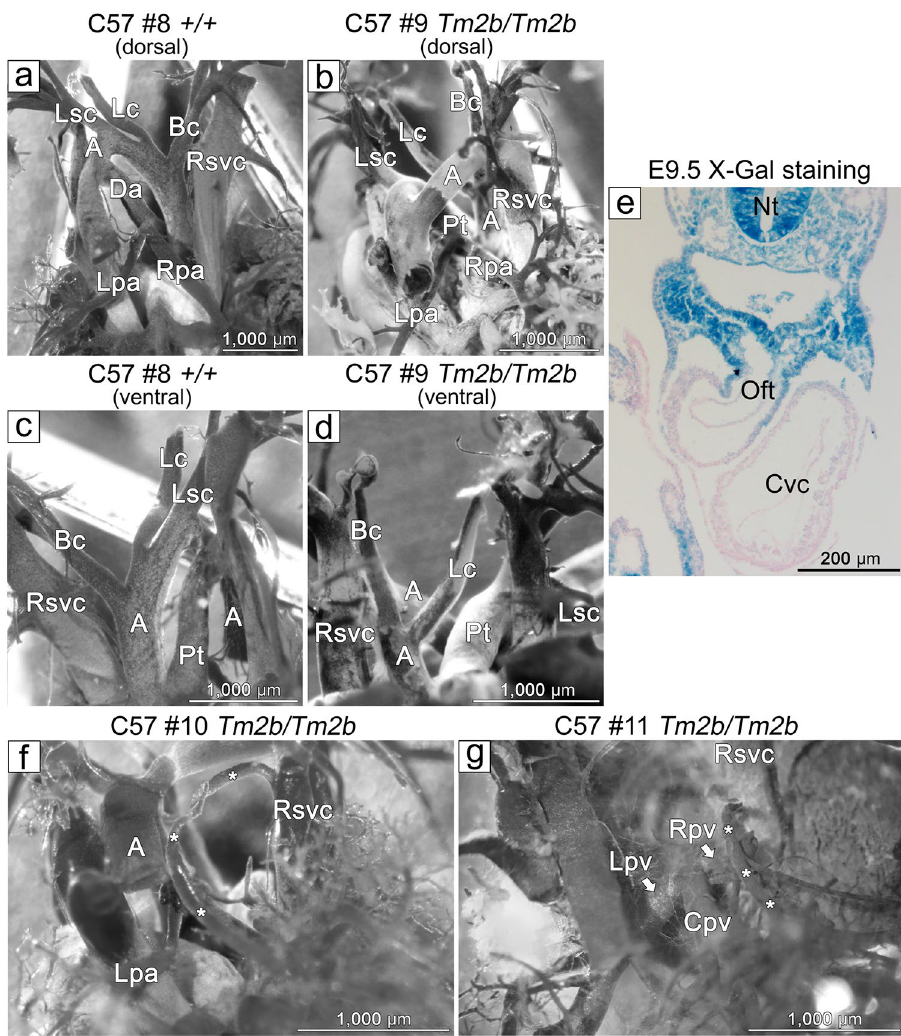
Figure 6. Other heart defects resulting from loss of CECR2. Embryonic resin heart casts revealed that 1/7 C57Bl/6N Cecr2 Tm2b/Tm2b embryos ( b dorsal, d ventral) showed what appears to be right aortic arch with isolated left subclavian artery (Lsc) compared to a normal embryo ( a dorsal, c ventral). The Lsc arises from the pulmonary tract/ductus arteriosus rather than the aorta. X-gal staining of a Cecr2 GT/GT E9.5 embryo ( e ) shows Cecr2 expression in the outflow tract (Oft) of the heart, which becomes the ascending aorta and pulmonary tract. In 2/7 C57Bl/6N Cecr2 Tm2b/Tm2b embryos ( f , g ), an aberrant vessel (marked along the length with asterisks) was seen coming from the right lung and draining into the right superior vena cava. A-aorta, Bc-brachiocephalic artery, Cpv-central pulmonary vein, Cvc-common ventricular chamber, Da-ductus arteriosus, Lc-left carotid artery, Lpa-left pulmonary artery, Lpv-left pulmonary vein, Lsc-left subclavian artery, Nt-neural tube, Oft- outflow tract, Pt-pulmonary tract, Rpa-right pulmonary artery, Rsvc-right superior vena